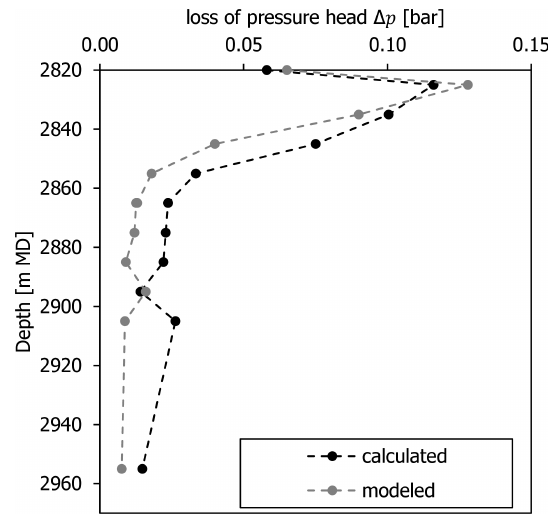
Figure 5. Comparison of pressure loss at the main flow zone esti- mated as input for Emeraude modelling with analytically calculated pressure